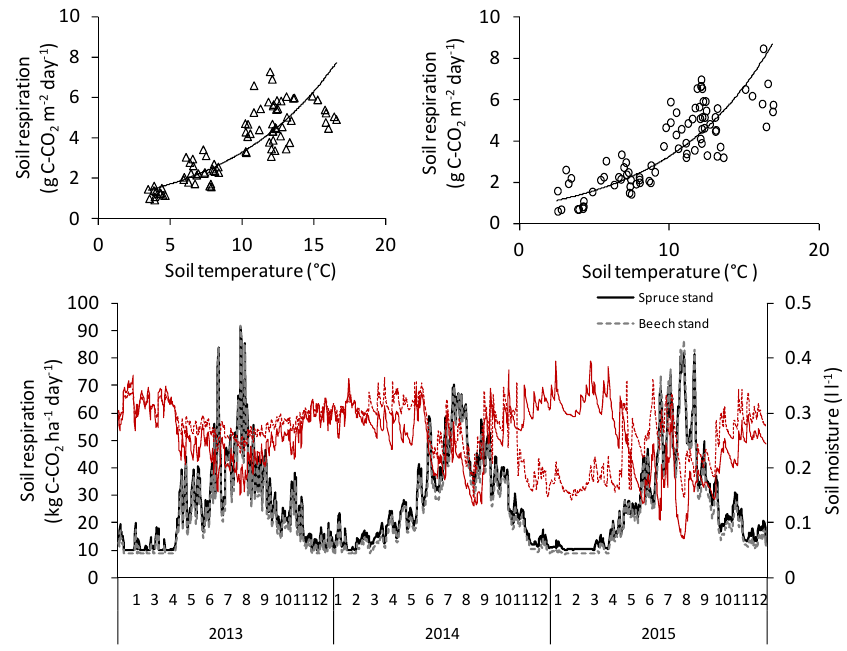
Figure 1. Measured soil efflux (g ∙ m − 2 ∙ day − 1 ) of C and corresponding soil temperature (°C) in spruce (left) and beech (right) stands, and (lower panel) modelled daily soil respiration (kg ∙ ha − 1 ∙ day − 1 ) in spruce (black solid line) and beech (grey dashed line) stands for the period 2013–2015. Soil moisture under the forest floor was measured in the spruce stand (solid red line) and in the beech stand (dashed red line) for the period 2013–2015. Table 6. Stand ‐ specific exponential relationships between soil temperature (°C) and soil respiration (g C ∙ m − 2 ∙ day − 1 ). Intercept ( α ), exponential coefficient ( β ), Q 10 , R 10 , r 2 , number of measurements ( n ) and p value.